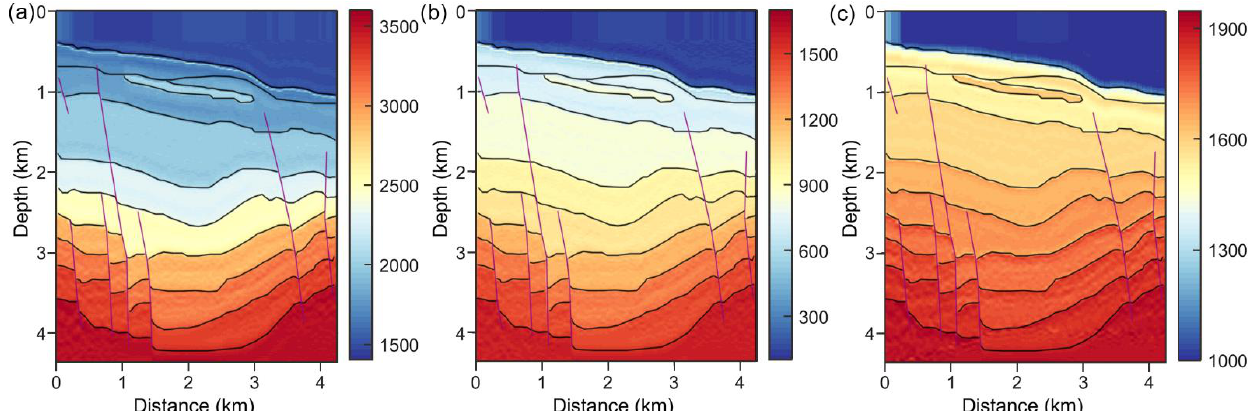
Figure 14. The inverted models from the noisy data using the wave-equation-based inversion method: ( a ) P-wave velocity, ( b ) S-wave velocity, and ( c ) density. The black lines indicate the stratigraphic horizons and the red lines indicate the faults.